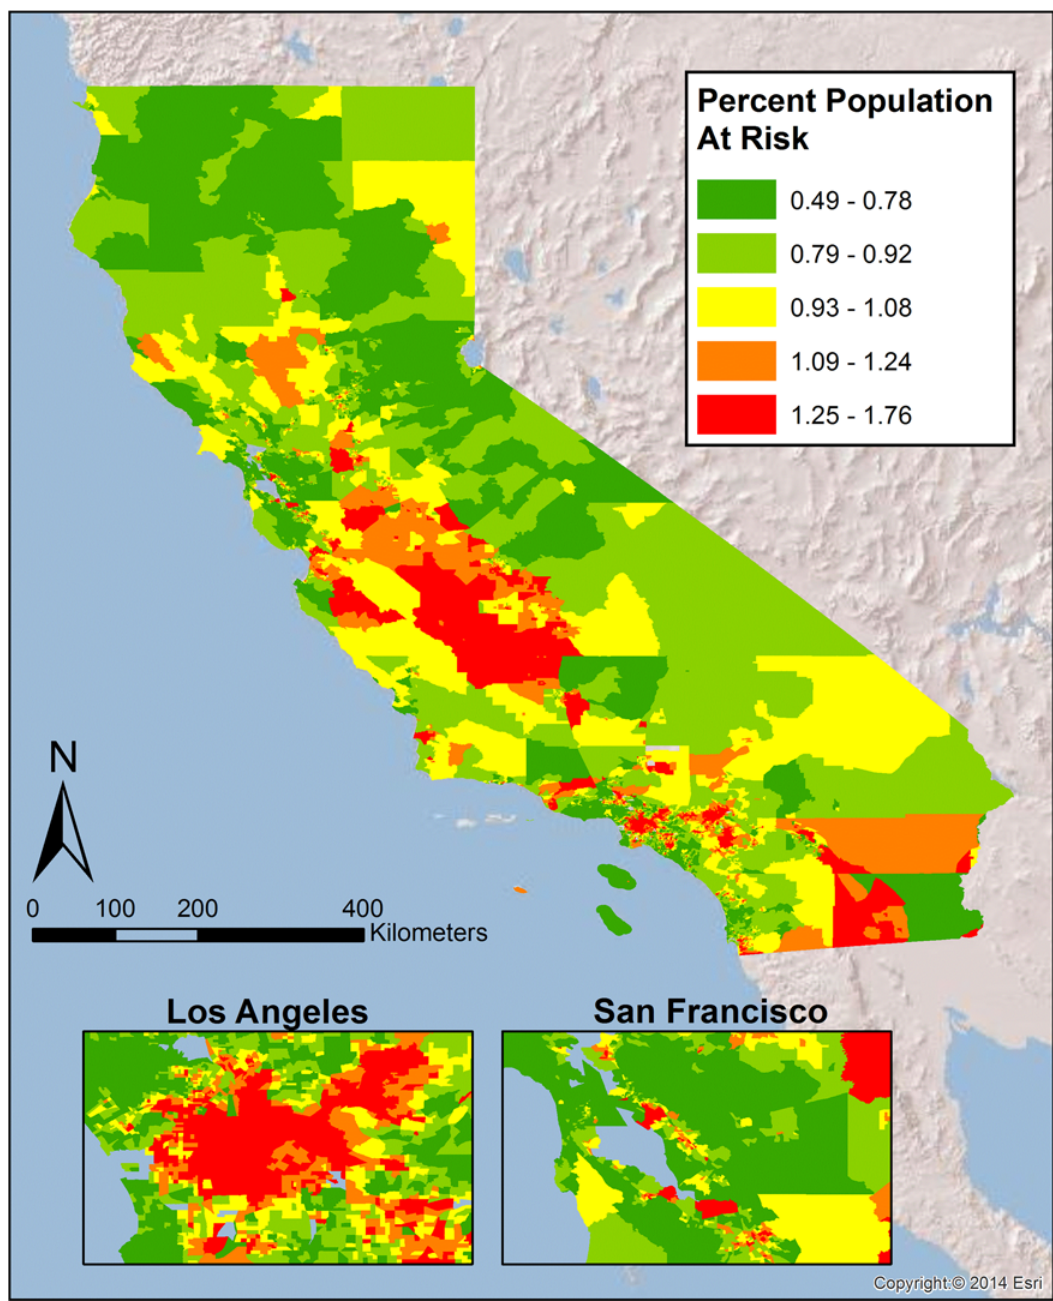
Fig 2. Percent of total population at increased risk of developing T2DM. Geographic distribution across the state of California for percent of population at increased risk of developing T2DM due to the rs13266634 single nucleotide